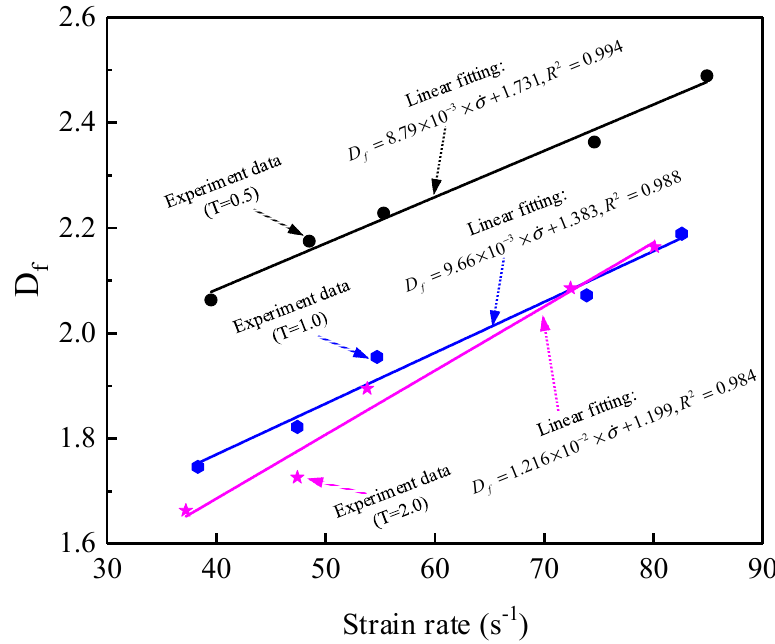
Figure 19. Dependence of fractal dimension on strain state in the S 5 series samples. Particle size distributions are represented by Talbot indices T = 0.5, 1.0, and 2.0.